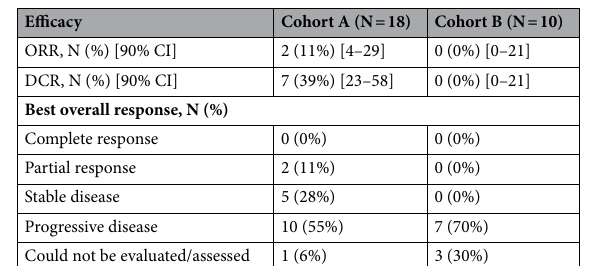
Table 2. Anti-tumor activity assessed by RECIST v1.1. ORR objective response rate, DCR disease control